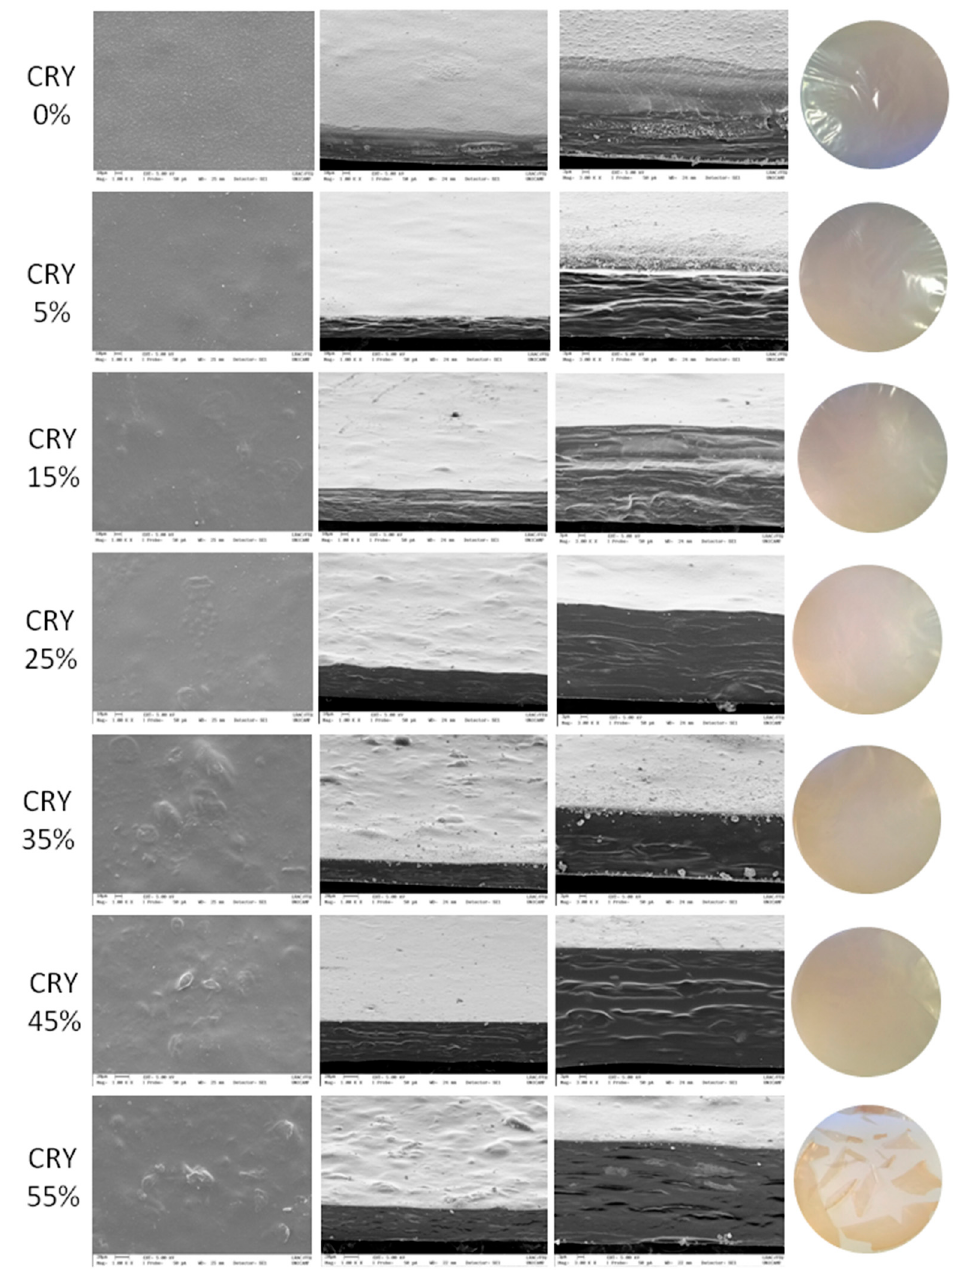
Figure 1. Scanning electron microscopy (SEM) images of surface (column 2, images with 1000 × magnification), cross section (column 3, images with 1000 × magnification, and column 4, images with 3000 × magnification), and photographic images (column 5) of the edible films based on arrowroot starch and gelatine incorporated with 0, 5, 15, 25, 35, 45 and 55% cranberry.